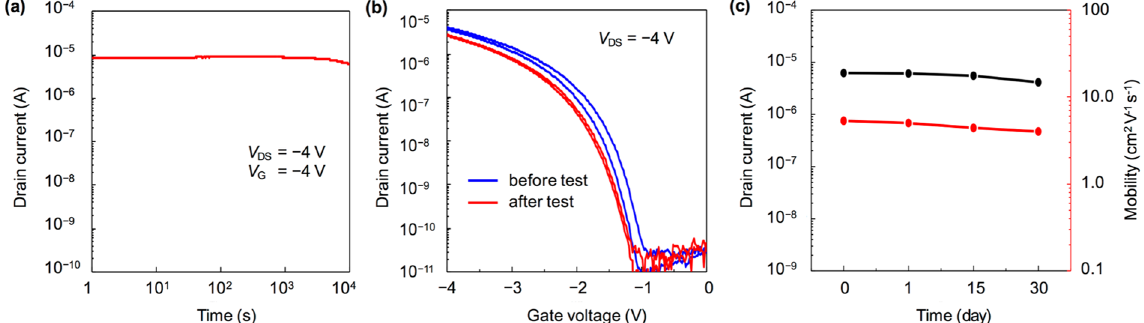
Figure 4. ( a ) Bias-stress characteristics of a C 8 -BTBT-based OFET. Bias-stress measurements were conducted in the ambient condition. The drain and gate voltages were both − 4 V. ( b ) Transfer curves before and after the bias-stress test. ( c ) Stability characteristics of the C 8 -BTBT-based OFET.